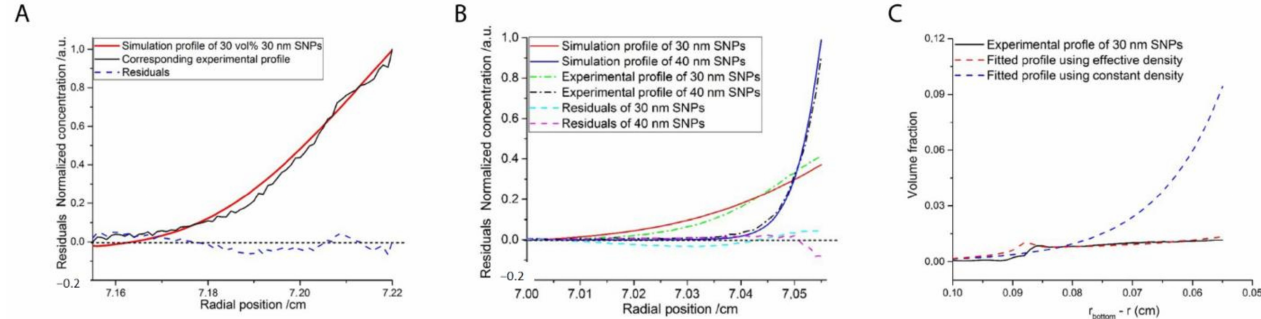
Figure 8. ( A ) Normalized experimental (black line) and simulation (red line) concentration ( c ) gradients for 30 nm hard-sphere-like silica nanoparticles of an initial concentration of 30 vol% in an AUC-SE experiment at 2800 rpm; the root-mean-square deviation (RMSD) value is 0.034% and the blue line corresponds to the deviation between experimental and simulation data; ( B ) Normalized experimental (dash dotted lines) and simulation (solid lines) concentration gradients for a binary hard sphere mixture of 30 nm (3.3 vol%) and 40 nm (6.7 vol%) silica nanoparticles in an AUC-SE experiment at 2800 rpm and the dashed line corresponds to the deviation between experimental and simulation data; ( C ) Experimental (solid line) and simulation (dashed lines) concentration gradients for 30 nm silica nanoparticles in a binary hard sphere mixture of 30 nm (1 vol%) and 90 nm (9 vol%) silica nanoparticles in an AUC-SE experiment at 2800 rpm, with the simulation profiles using the constant solvent density (blue dashed line) and the effective density (red dashed line); Reproduced with permission from [103], Copyright the American Chemical Society, 2019, and [106], Copyright Wiley-VCH,